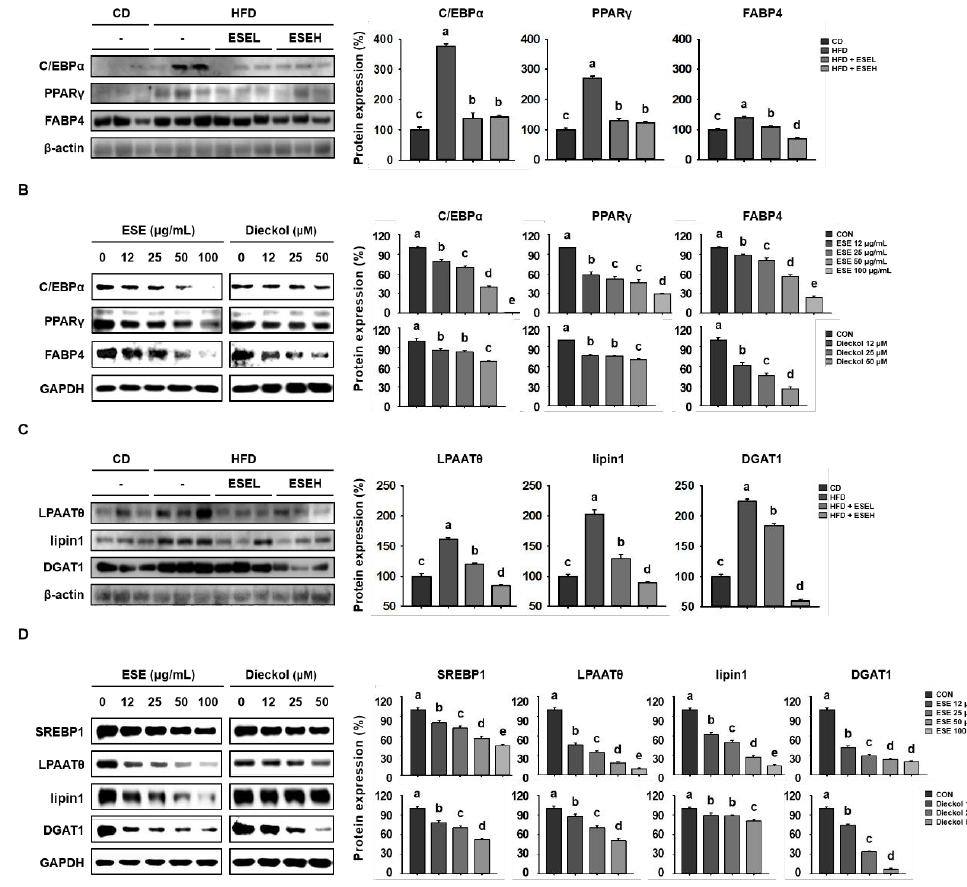
Figure 3. E ff ects of ESE on the expression of adipogenic and lipogenic proteins in HFD-fed mice and 3T3-L1 adipocytes. ( A ) Western blots of adipogenic proteins (CCAAT / enhancer-binding protein alpha (C / EBP α ), peroxisome proliferator-activated receptor gamma (PPAR γ ), and fatty acid-binding protein 4 (FABP4)) in WAT. ( B ) Western blots of adipogenic proteins in 3T3-L1 cells. ( C ) Western blots of lipogenic proteins (lysophosphatidic acid acyltransferase theta (LPAAT θ ), lipin1, and diacylglycerol acyltransferase 1 (DGAT1)) in WAT. ( D ) Western blots of lipogenic proteins (sterol regulatory element-binding protein 1 (SREBP1), lysophosphatidic acid acyltransferase theta (LPAAT θ ), lipin1, and DGAT1) in 3T3-L1 cells. Data are expressed as means ± SDs (n = 4). Values with di ff erent letters